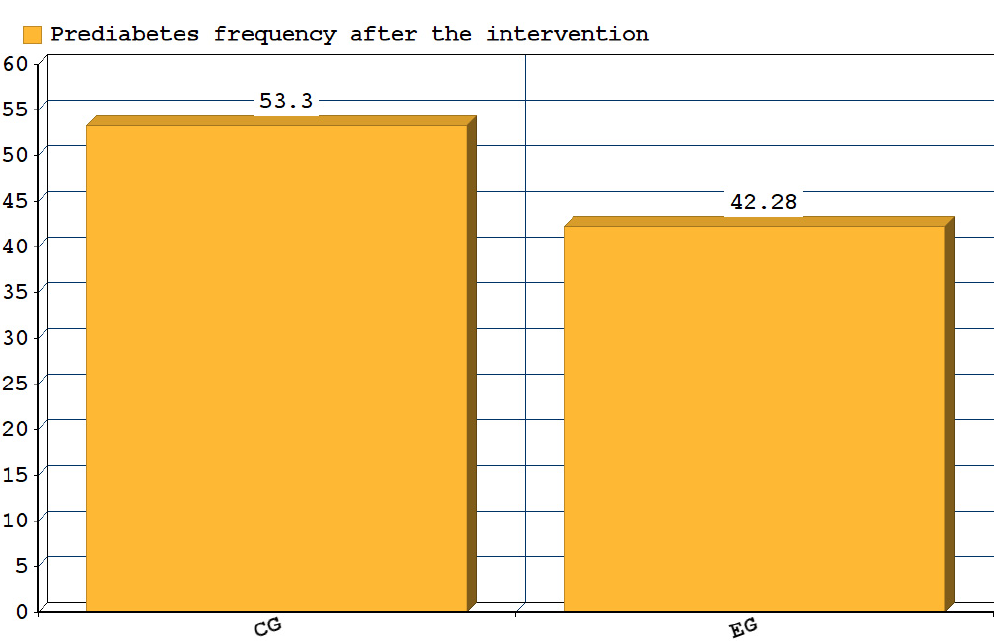
Figure 4. Prediabetes frequency after the intervention (V4) in the control and experimental group.